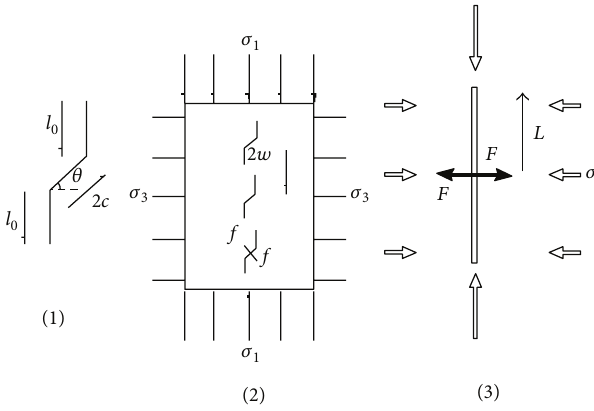
Figure 8: Simplified model of